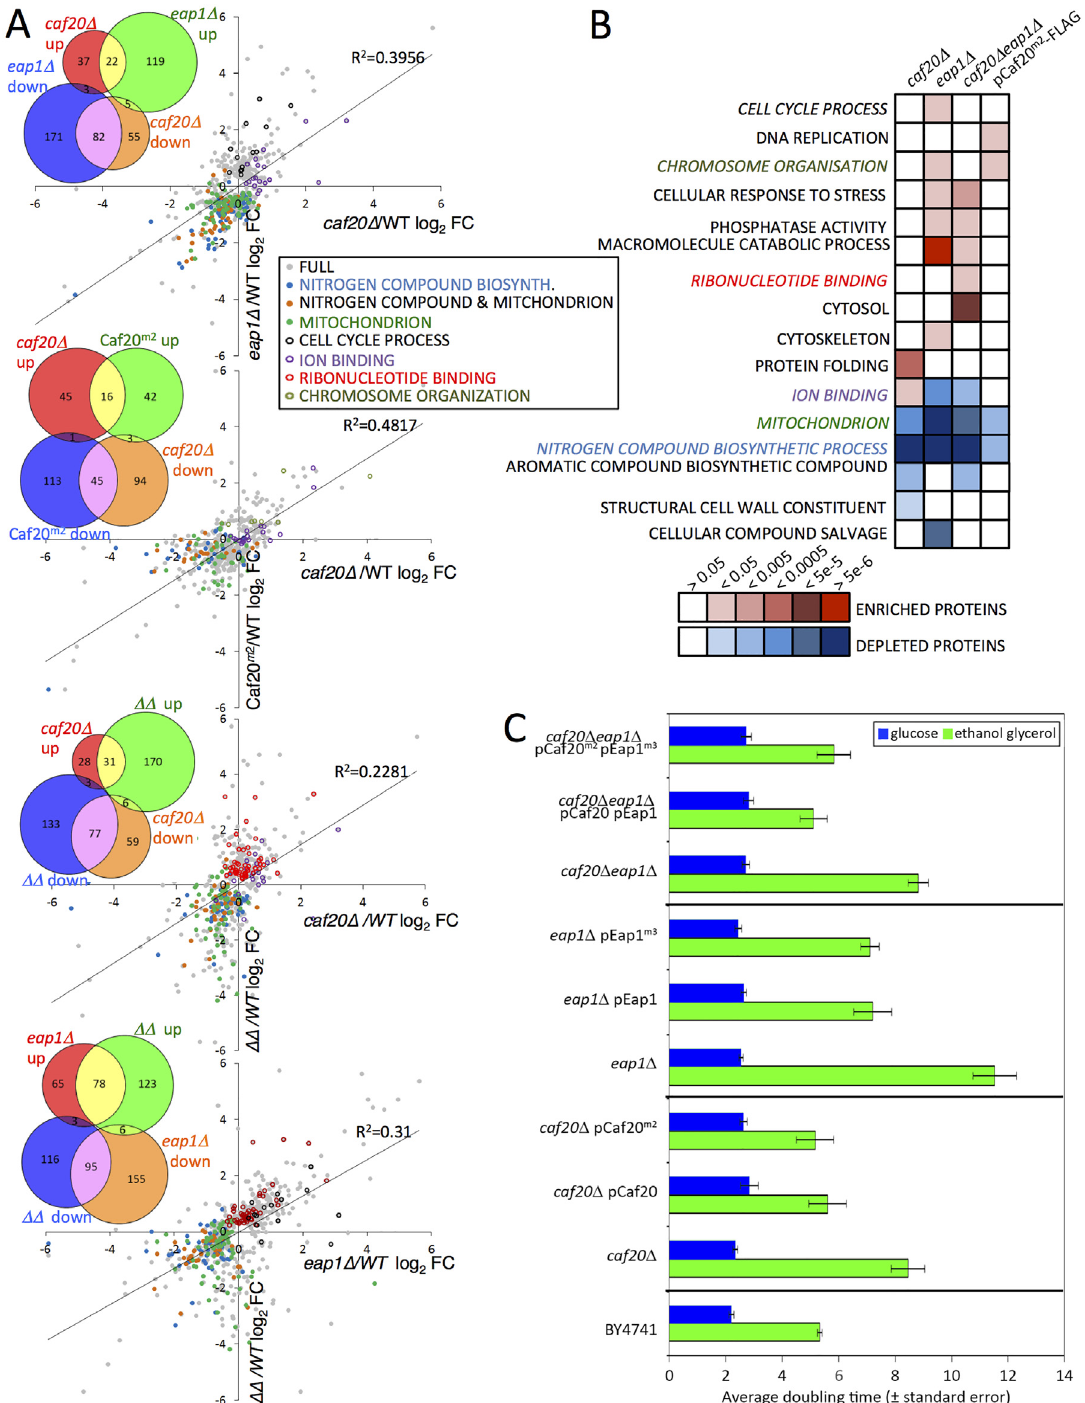
Fig 3. The altered proteome of single, double 4E-BP Δ and Caf20 m2 -FLAG strains. A. Pairwise comparisons of changes to proteome profiles for the 4E-BP Δ strains plotting log2 fold changes (log2FC) of each mutant strain to wild type (WT), showing only significantly changing proteins (FDR < 0.05, 2 or more peptides used for quantification). Highlighted are key Gene Ontology (GO) classes that are over/under-represented. Colours are indicated in the inserted key. Lines of best fit and R 2 correlation coefficients are shown. Four inset Venn-style diagrams in each upper left quadrant indicate numbers of proteins shared between datasets. ΔΔ indicates the double caf20 Δ eap1 Δ strain. B. Functional GO class analysis of the 4E-BP Δ and Caf20 m2 -FLAG altered proteomes using the DAVID Bioinformatics database. Over/underrepresentation colours depict FDR significance as per the key. Coloured text GO terms are highlighted in A. Only a representative selection of the significant functional categories is shown. C. Mean doubling times of the BY4741 (Wild type) and